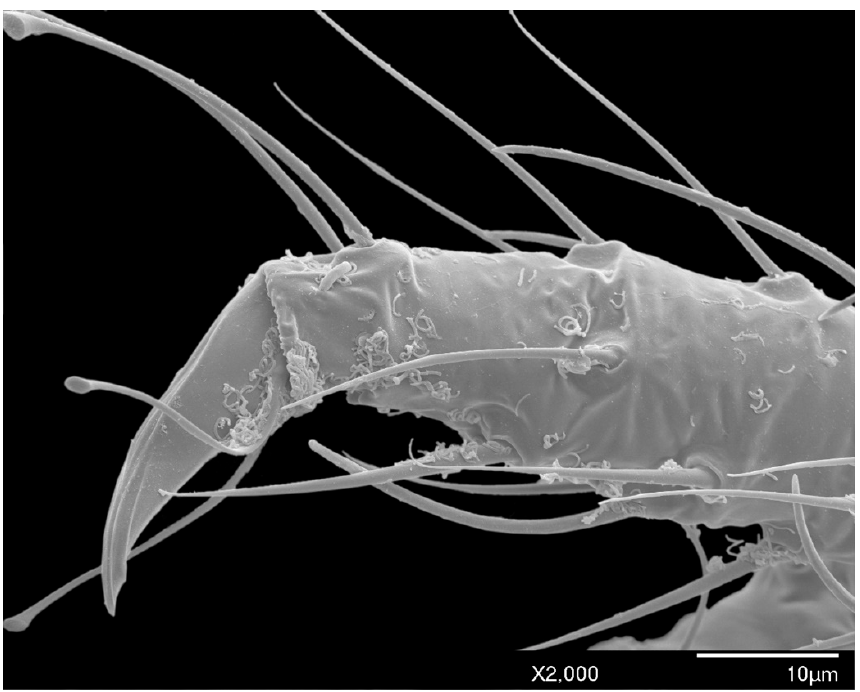
Figure 7. SEM of the male A. galliformis tarsus, tarsal digitules, ungual digitules, and claw. Wax excretions are present on the tarsus and proximal portion of the claw.